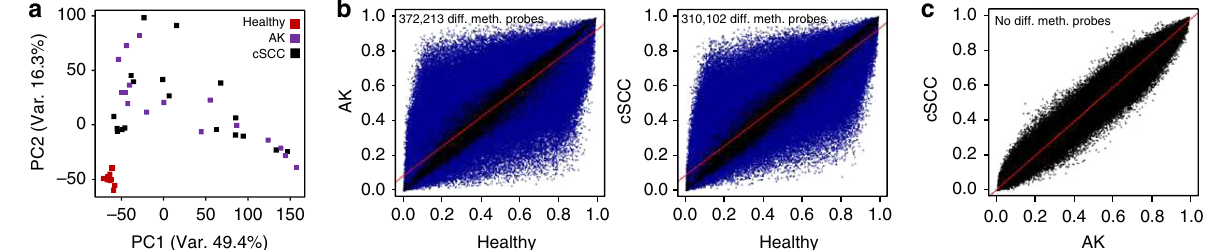
Fig. 1 Actinic keratosis (AK) and cutaneous squamous cell carcinoma (cSCC) show similar aberrant methylation patterns. a Principal component analysis of 12 healthy, 16 AK, and 18 cSCC epidermis samples using all 850k CpG probes. b Scatter plots comparing the epidermis methylomes of healthy and AK samples (left panel), and healthy and cSCC samples (right panel). Differentially ( P < 0.05, F -test) methylated probes are shown in blue. c Scatter plot comparing the epidermis methylomes of AK and cSCC samples. No signi fi cantly ( P < 0.05, F -test) differentially methylated probes were